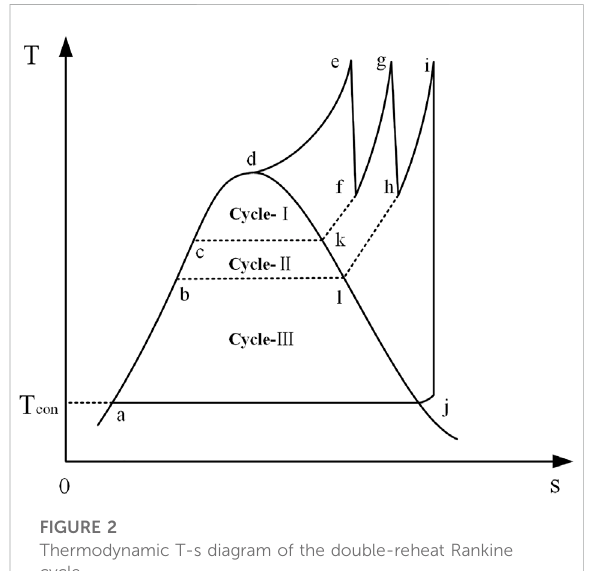
FIGURE 3 Thermodynamic T-s diagram of micro-cycle